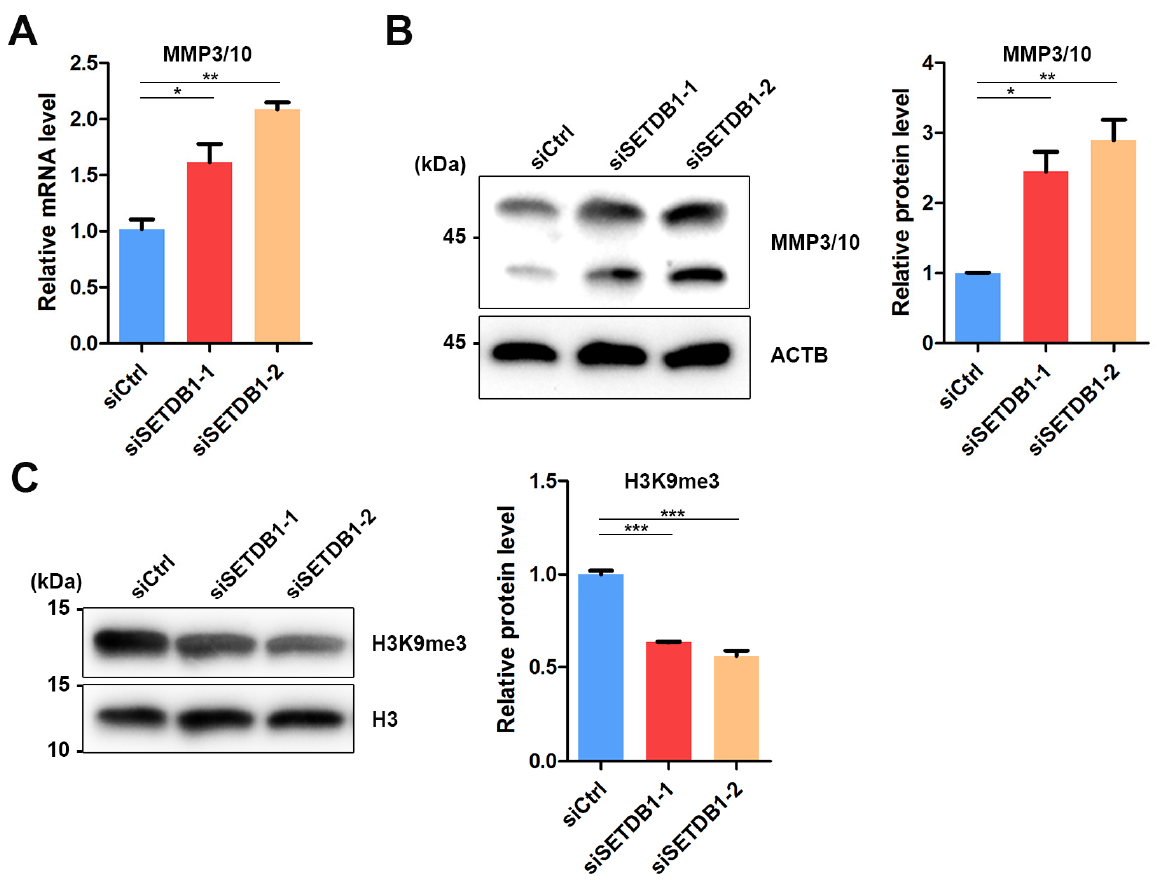
Figure 5. SETDB1 regulated MMP3/10 expression in porcine SSCs. ( A ) qRT-PCR analysis of the relative mRNA level of MMP3/10 in porcine SSCs. ( B ) Western blot analysis of the protein levels of MMP3/10 and ACTB in porcine SSCs. The protein level of MMP3/10 relative to ACTB is shown in the column diagram. ( C ) Western blot analysis of the protein levels of H3K9me3 and histone H3 in porcine SSCs. The protein level of H3K9me3 relative to histone H3 is shown in the column diagram. Significance was presented as * p < 0.05, ** p < 0.01 or *** p < 0.001. Error bars represented the standard error of the mean (SEM).